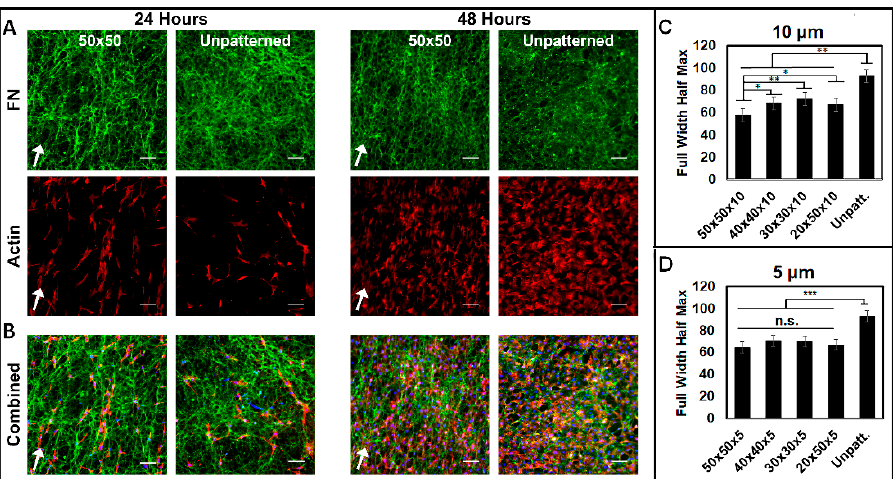
Figure 6. Decellularized ECM (dECM) that was recellularized shows alignment of cells along matrix